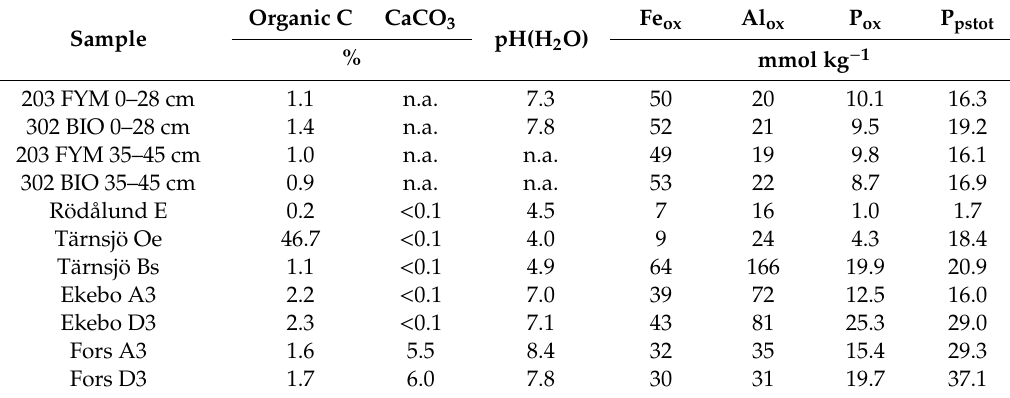
Table 1. Basic properties of the soil